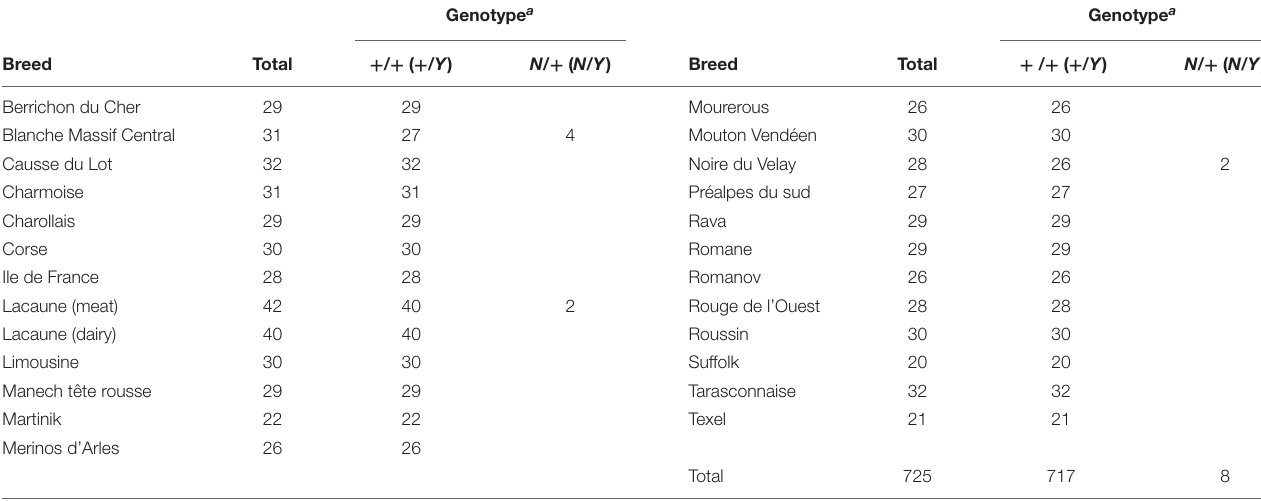
TABLE 3 | FecX N genotype distribution from a diversity panel of French ovine breeds.